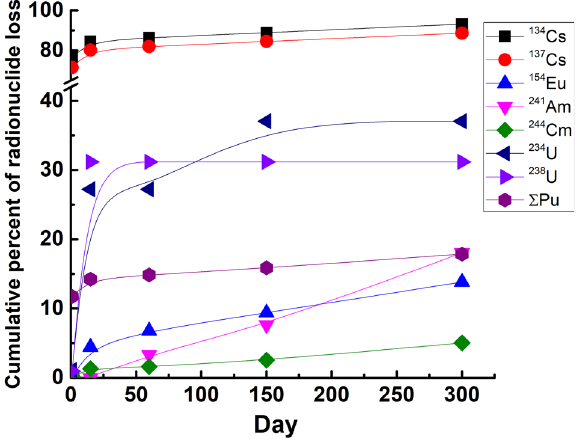
Fig. 4 Dynamics of leaching of fuel-related radionuclides. The sample of a block graphite was an irregular lump with mass 15.5 mg. The lines are drawn to guide an eye.